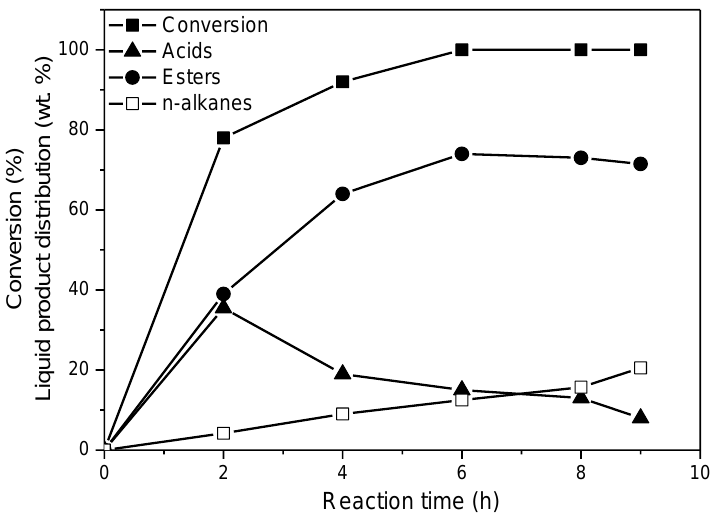
Figure 12. Conversion (%) of WCO achieved over the 20Ni2Mo/MM(H) catalyst and the liquid product distribution (wt.%) obtained at various reaction times (reaction conditions: 100 mL of WCO, 𝑃 𝐻 = 40 bar, T = 310 °C and H 2 flow = 100 mL/min). 2